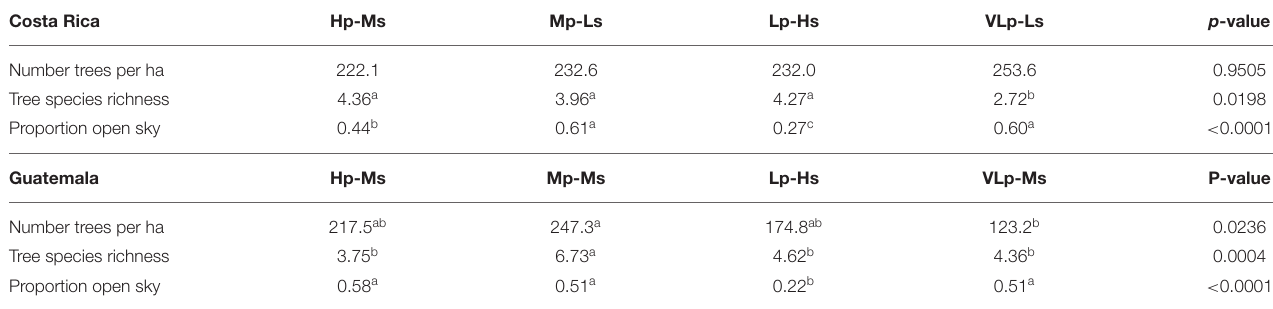
TABLE 3 | Shade characteristics for coffee plantation typologies (key to typology codes see Table 2 ). Costa Rica